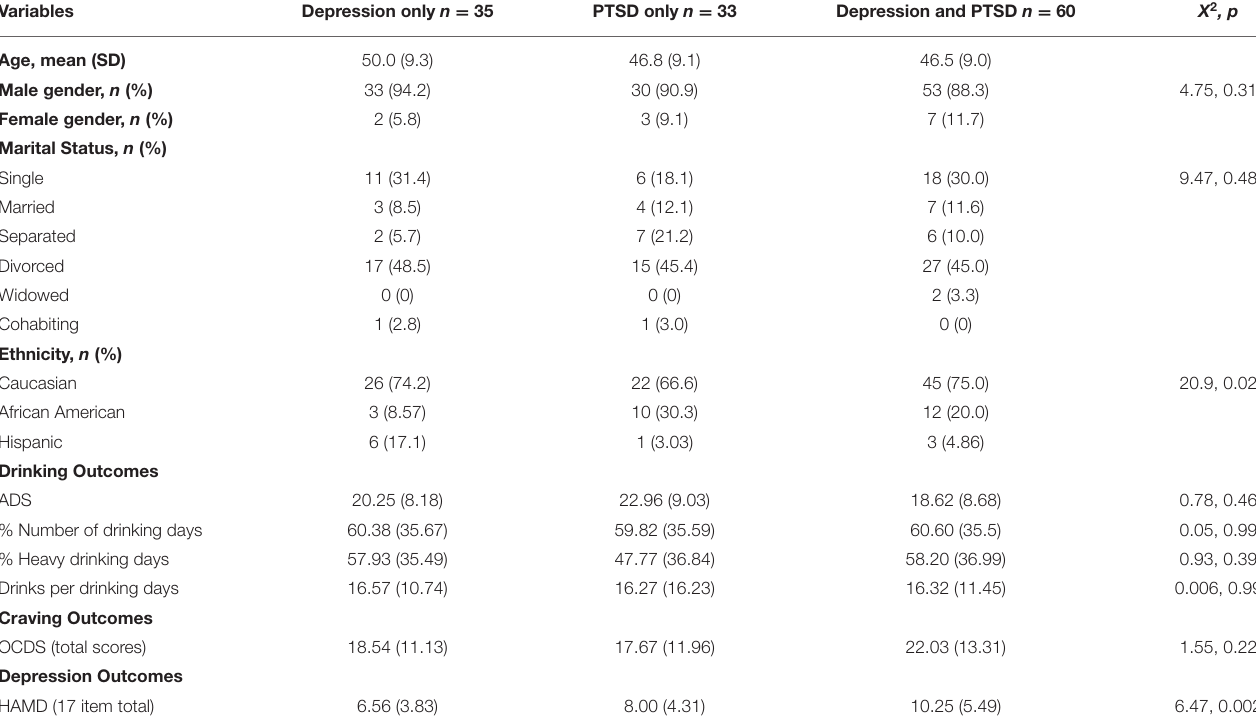
TABLE 1 | Demographic and clinical characteristics of the sample.